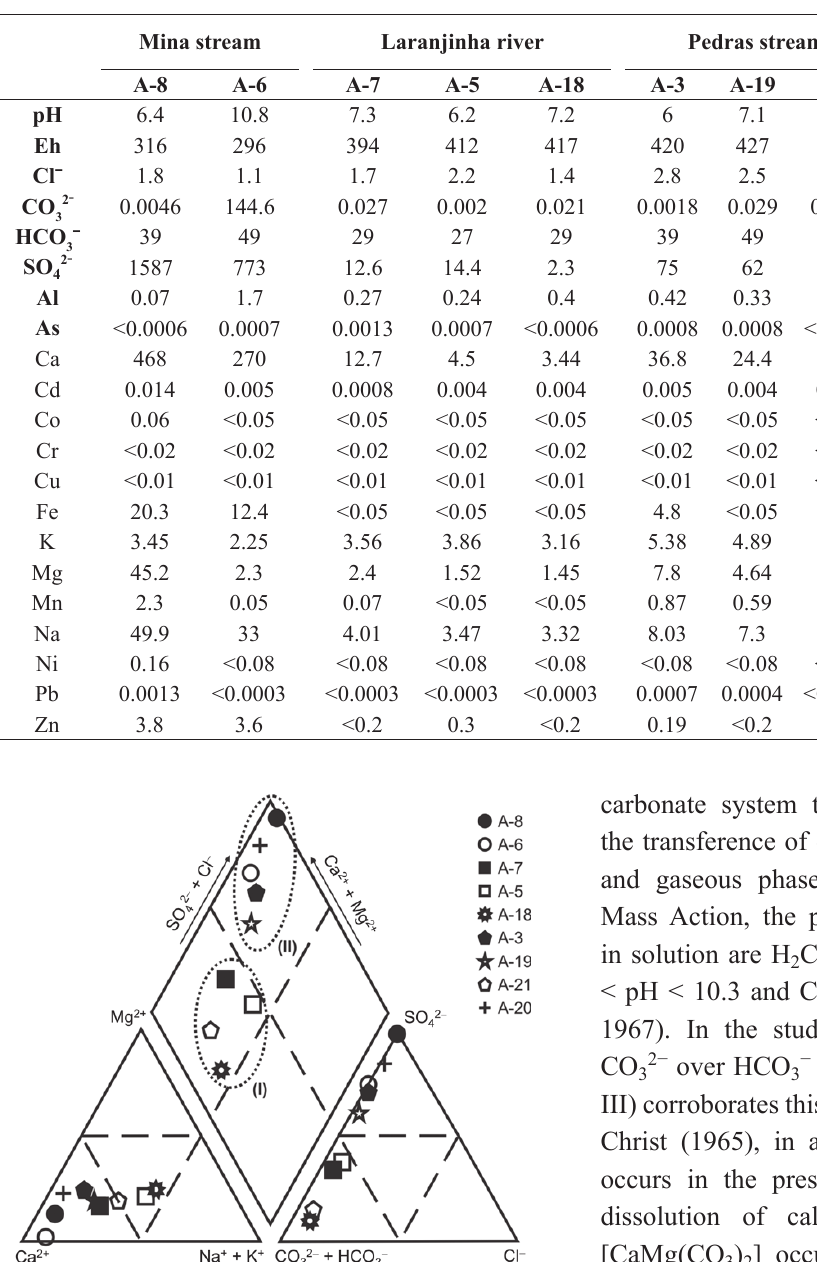
Values of pH, Eh (mV) and chemical concentrations (in mg L −1 ) of surface water samples. Values shown with the “less than”symbol (“<”) are detection limits, and CONAMA (Environmental National Council) values (in mg L −1 , except pH) are water quality standards (class 2) of the Brazilian legislation (BRAZIL 2005). Contents of CO 32- were calculated by means of the GwCHART program (Winston 2000).